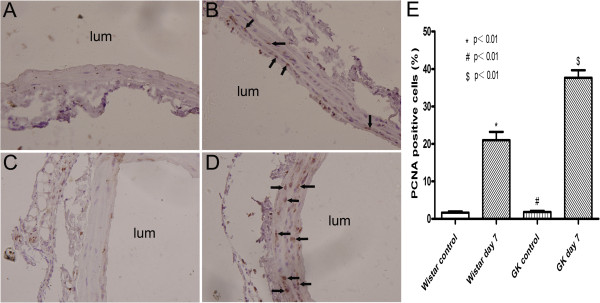
Representative immunohistochemical photomicrographs for PCNA expression in common carotid arteries (magnification ×400). (A) Wistar rats control. (B) A large number of PCNA positive cells were observed in Wistar rats at day 7 after balloon injury. (C) GK rats control. (D) Strong PCNA immunostaining was seen in GK rats at day 7 after balloon injury. (E) The percentage of PCNA positive cells in Wistar and GK rats after balloon injury increased significantly as compared to Wistar and GK rats control respectively. The percentage of PCNA positive cells in Wistar rats was significantly less than in GK rats. Arrows in images sign PCNA positive cells and lums indicate luminal side of artery. * indicates Wistar control versus Wistar day 7, # indicates GK control versus GK day 7, $ indicates Wistar day 7 versus GK day 7. p<0.01.